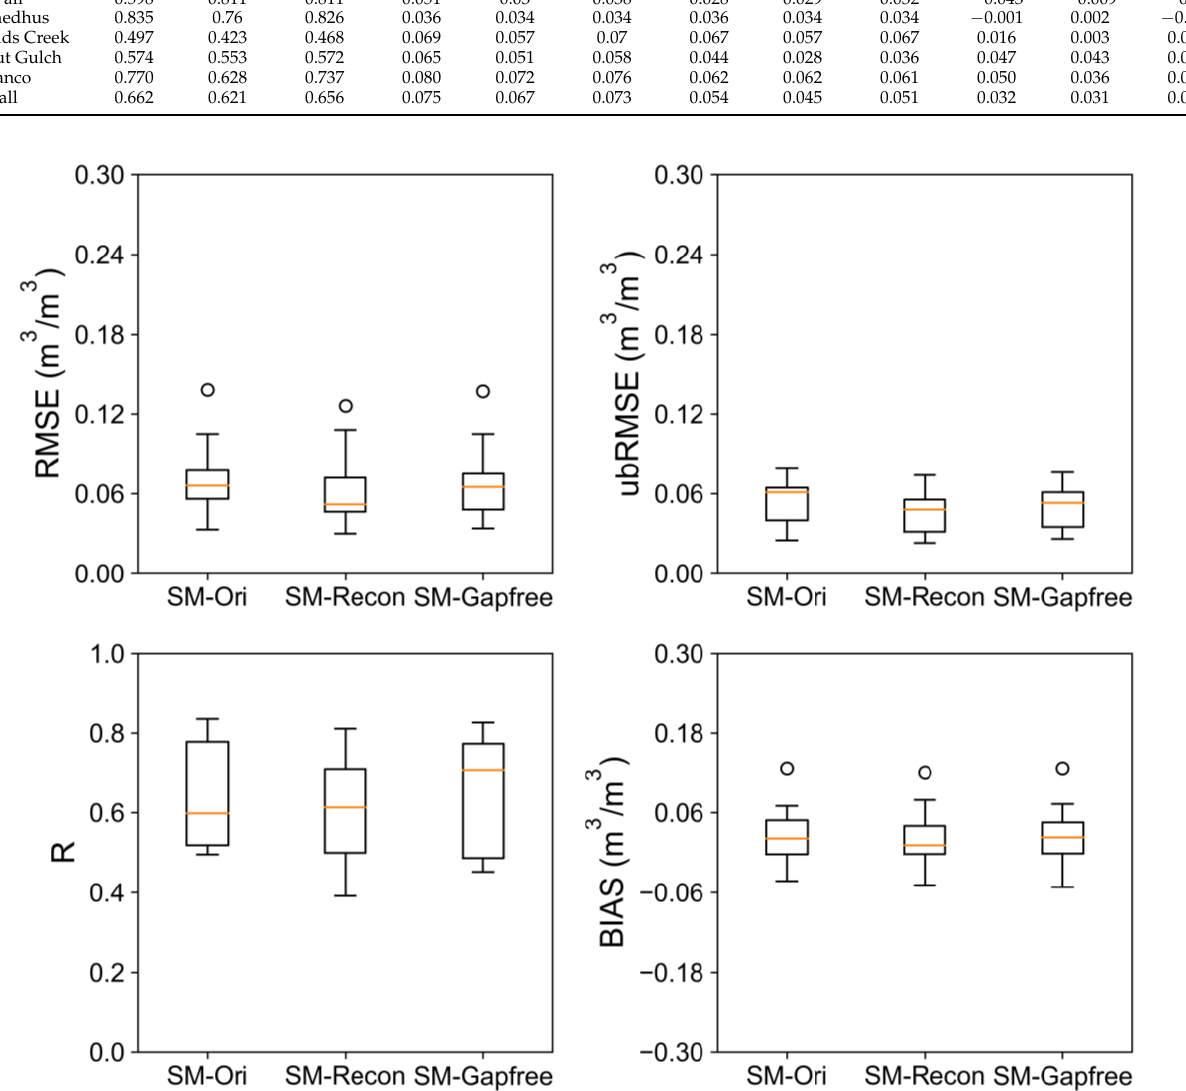
Figure 14. Boxplots of the SM-Ori, SM-Recon and SM-Gapfree products compared with the in situ SM observations.